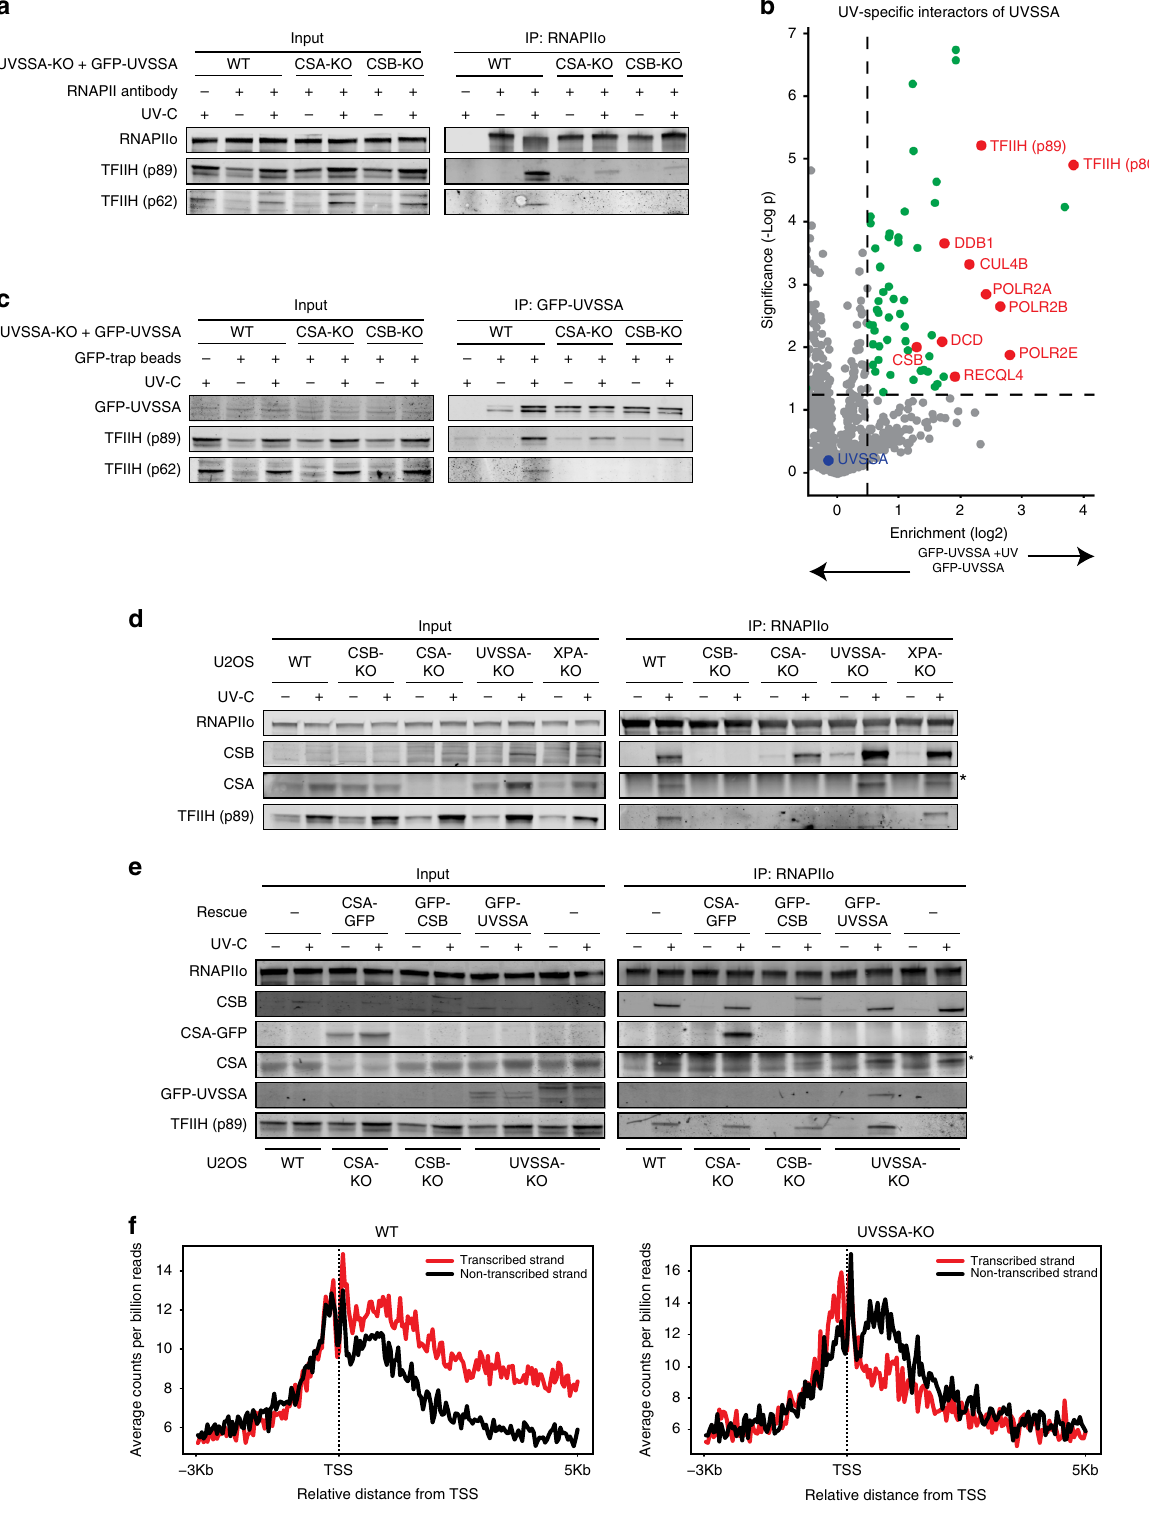
Fig. 7a; Supplementary Table 8), which revealed that CPD repair under these conditions is enriched on the transcribed strands within gene bodies consistent with TCR-mediated repair 46 . Importantly, the bias in CPD repair observed in transcribed strands was completely lost in both CSA-KO (Supplementary Fig. 7a) and UVSSA-KO cells (Fig. 5f). These fi ndings